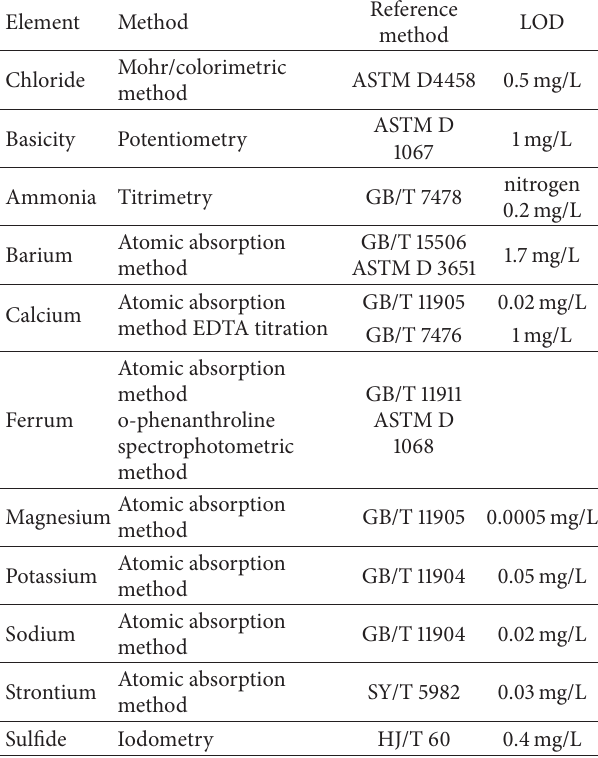
Table 3: Water quality test results (g/L).